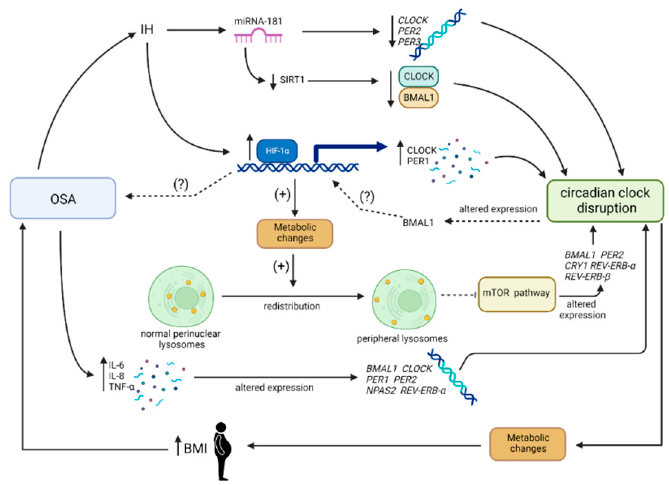
Figure 3. The bidirectional link between OSA and circadian clock disruption. Obstructive sleep apnea (OSA) is associated with the occurrence of recurring intermittent hypoxia (IH) episodes. In such conditions, a miRNA-181 family, which is oxygen-sensitive, is overexpressed. This leads to the silencing of miRNA-181-targeted genes, including, among others, CLOCK , PER2 , and PER3. Impaired clock gene fluctuations result in circadian clock disruption. Furthermore, miRNA-181 also targets the SIRT1 gene. SIRT1 deficiency leads to decreased CLOCK-BMAL1 levels, which triggers impaired circadian gene transcriptions and, finally, the development of circadian clock